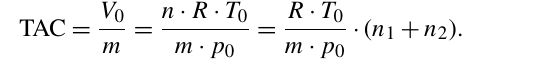
Figure 1. Scheme of the volumes involved in the TAC measure- ments. The gas from the refrozen meltwater in the vessel on the left is confined in the headspace volume V h . It is then expanded in the volume V exp = V 1 + V 2 = V h + V t + V 2 . The temperature T 2 in V 2 is held at − 60 ◦